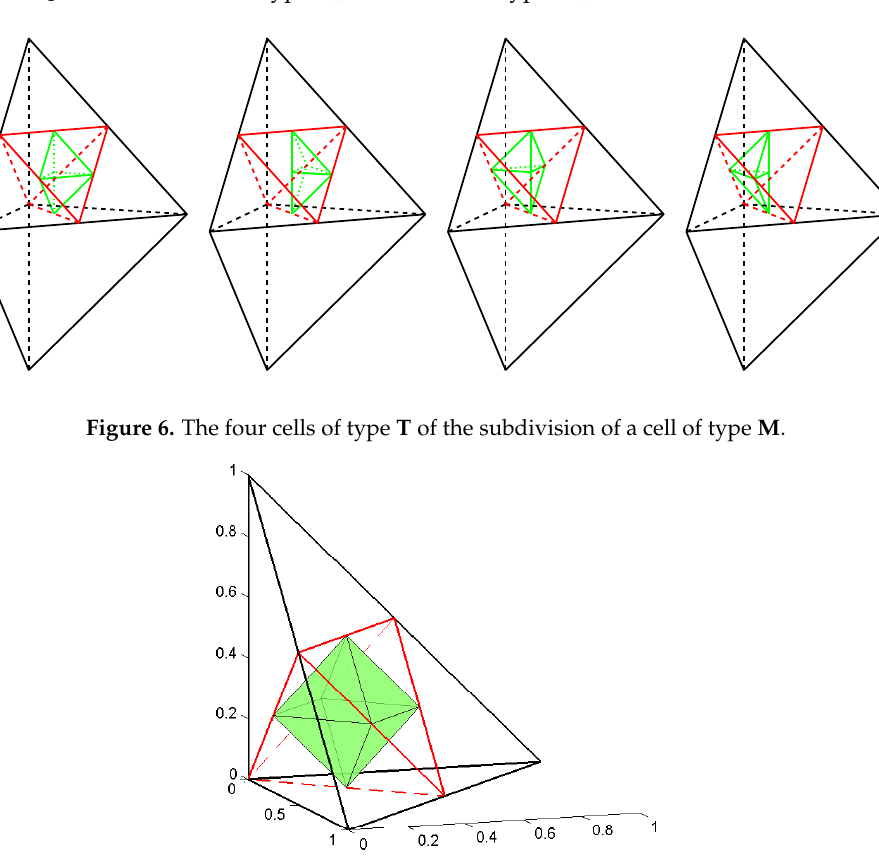
Figure 7. The subdivision of a cell of type M 1 into four cells of type M : the four tetrahedrons at the corners and four cells of type T in the middle, forming an